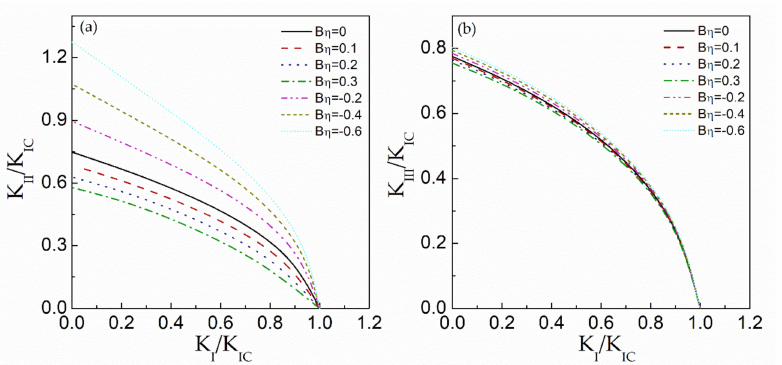
Figure 15. Mixed fracture toughness–predicted values of the fracture criterion under plane stress. ( a ) The mixed mode I/II fracture toughness–predicted values. ( b ) The mixed mode I/III fracture toughness–predicted